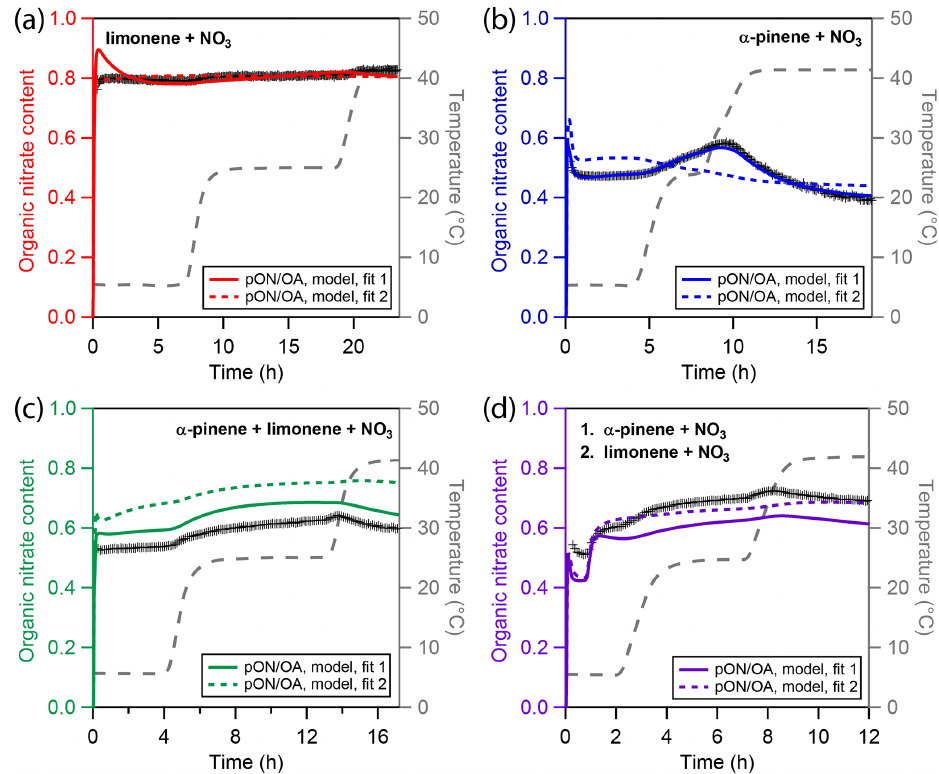
Figure 5. Experimental and modeling results of particulate organic nitrate content (pON / OA) for four different types of chamber-generated SOA. (a) Only limonene, (b) only α -pinene, (c) a mixture of α -pinene and limonene, and (d) sequential oxidation of firstly α -pinene and sec- ondly limonene. Cross markers are experimental nitration degrees inferred using a high-resolution time-of-flight aerosol mass spectrometer (HR-ToF-AMS). The colored solid and dotted lines represent results of the kinetic model. The grey dashed line indicates the experimental temperature